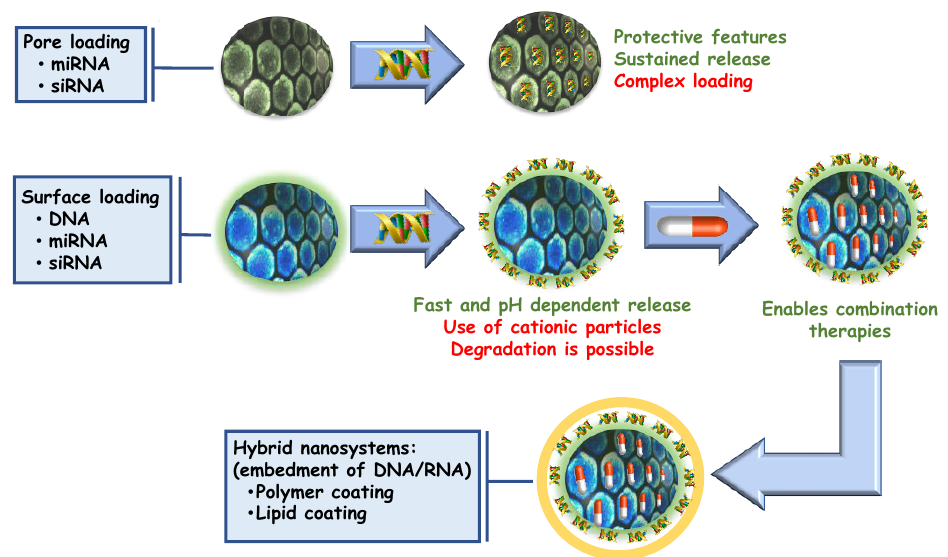
Figure 2. General strategies for nucleic acid drug delivery employing mesoporous silica nanoparticles.